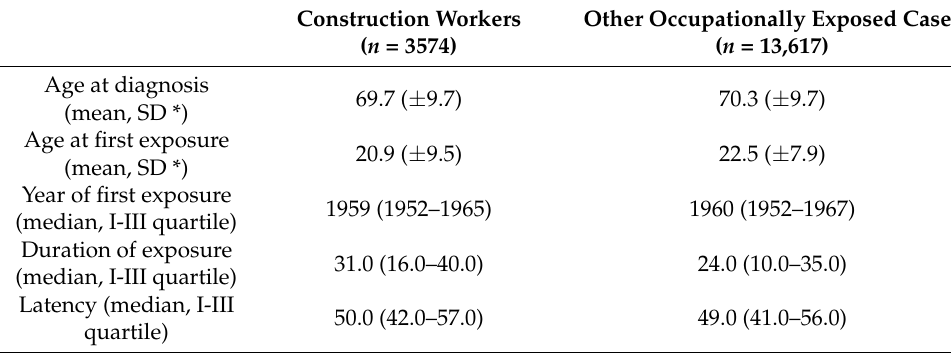
Table 2. Mean age at diagnosis, mean age and year of first exposure, duration of exposure and latency of MM by construction workers and other occupationally exposed subjects. Italy, ReNaM,